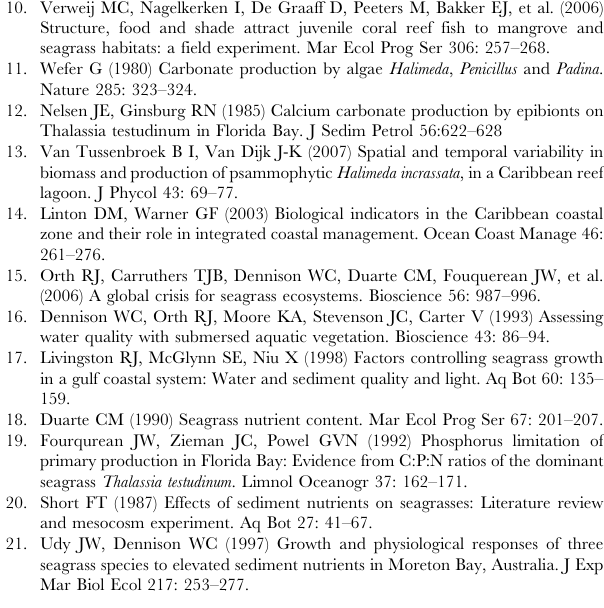
Table S4 Intra-annual variability in Thalassia testudi- num leaf productivity. Results of One-sample t-test for significant differences of D P (deviations from general mean leaf productivity) during High- and Low-growth season at different latitudes. H0: Average D P=0, a = 0.05. Table S5 Correlations between temperature, light and Thalassia testudinum leaf growth. Correlations between mean monthly SST (Sea Surface temperature, u C), H daylight (Hours of daylight) and shoot growth rates of Thalassia testudinum at USA-Florida Keys (Site 2, 1996–2003), Mexico-Puerto Morelos (Site 5, 1990–1991: from Van Tussenbroek BI [1995] Thalassia testudinum leaf dynamics in a Mexican Caribbean reef lagoon. Mar Biol 122: 33–40) and Tobago-Bon Accord Lagoon (Site 18, 1997–